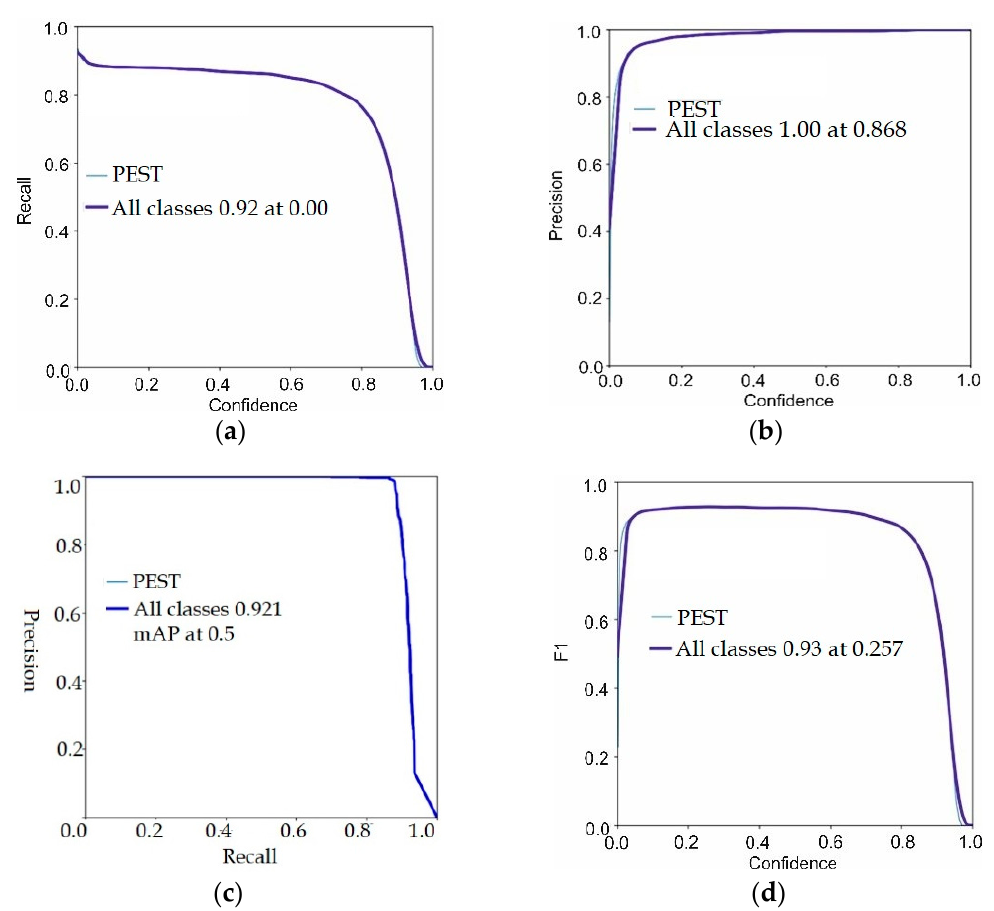
Figure 6. Proposed model validation results ( a ) precision, ( b ) mAP, ( c ) F1-score, ( d ) recall.